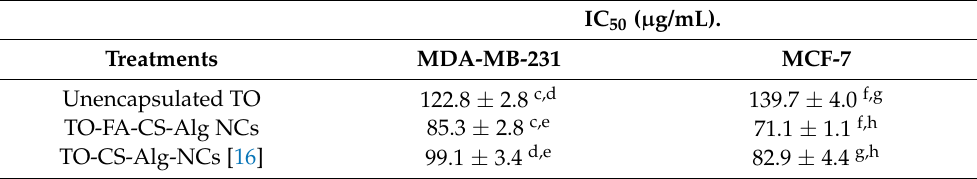
Table 4. Mean IC 50 values of the unencapsulated TO and formulated